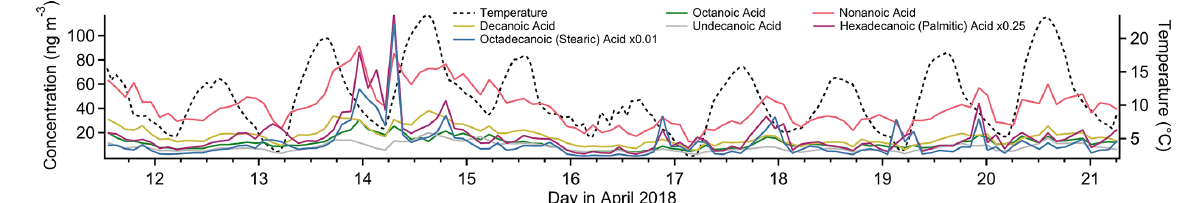
Figure 8. Timelines of select alkanoic acids (left axis) and temperature (right axis) for the study period.